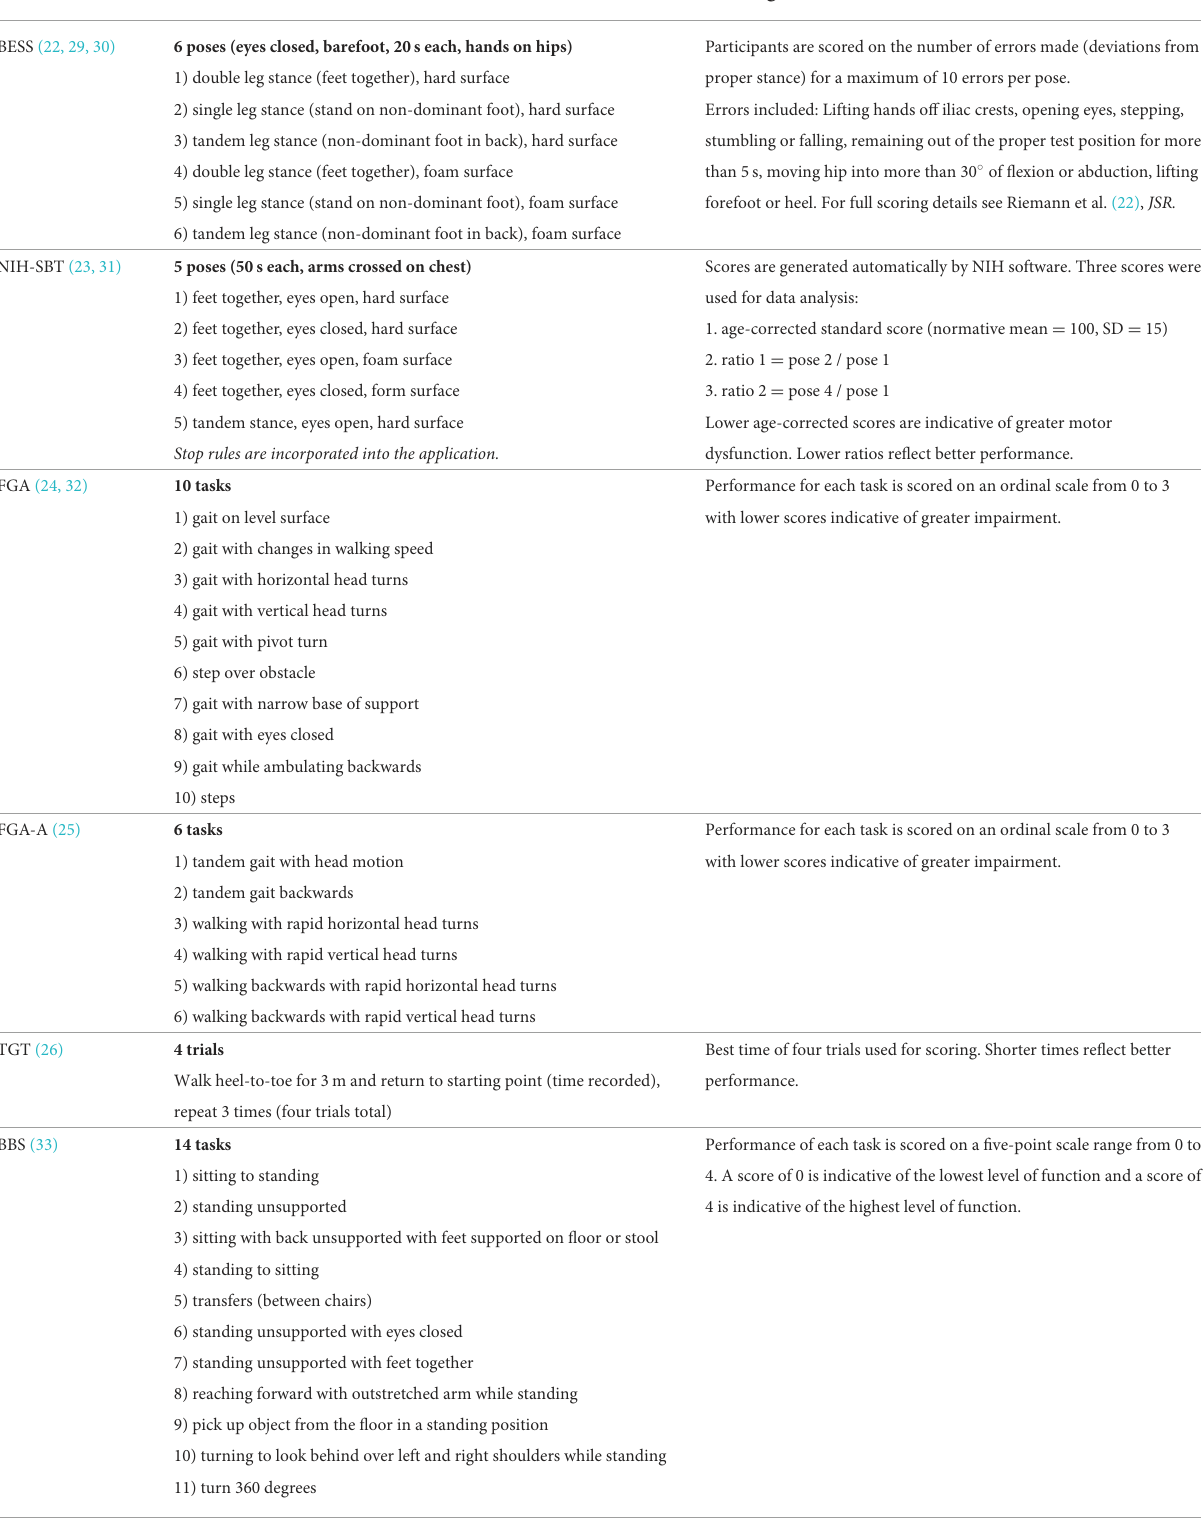
TABLE 1 Descriptive summary of balance test protocols and scoring of assessments included in the SiMPly Rehab balance testing